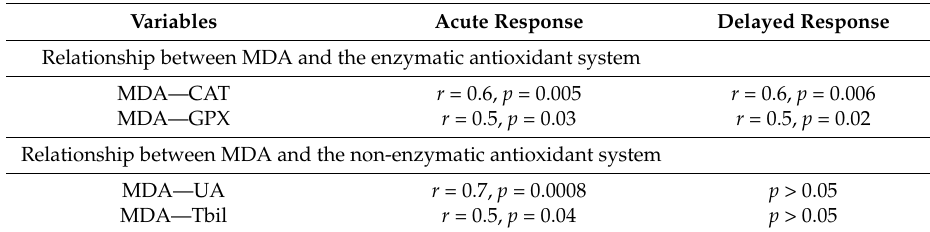
correlated (Table 3, Figure S2) to the enzymatic antioxidants CAT ( r = 0.6, p = 0.006) and GPX ( r = 0.5, p = 0.02). Table 3. Relationship between the lipid peroxidation and antioxidants measures ( ∆ rate of change % (POMj-PLA)) following a weightlifting training